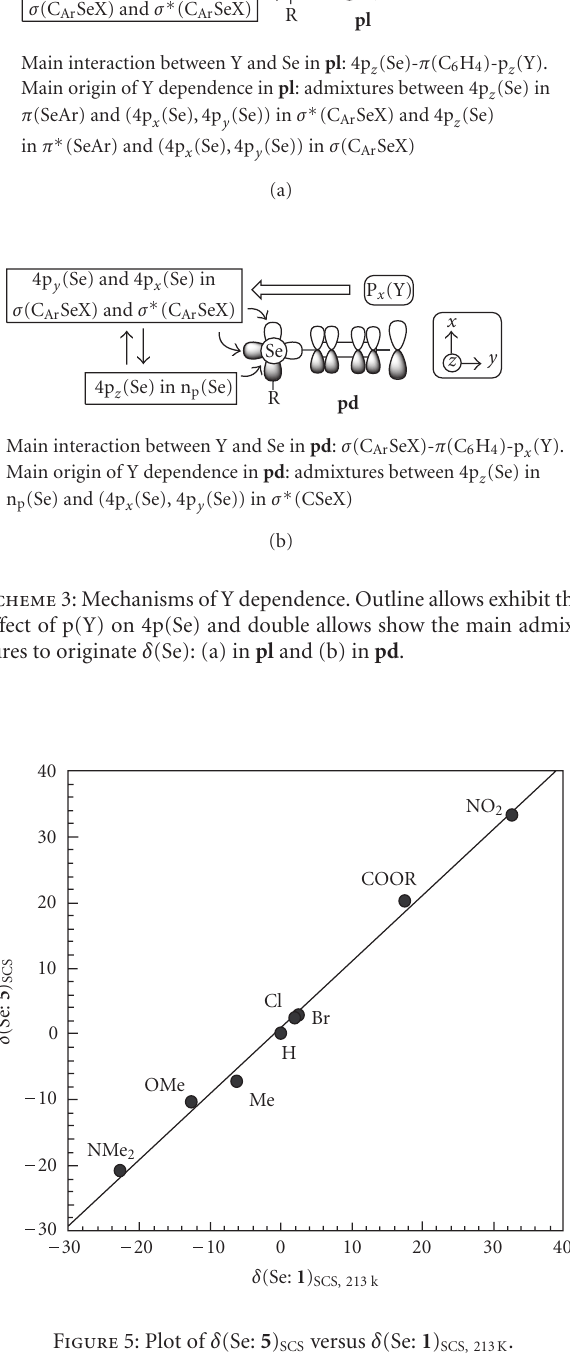
Structures of 1a – 3a in various conformers are also op- timized, containing frequency analysis, with the B3LYP/6- 311+G(d,p) method.